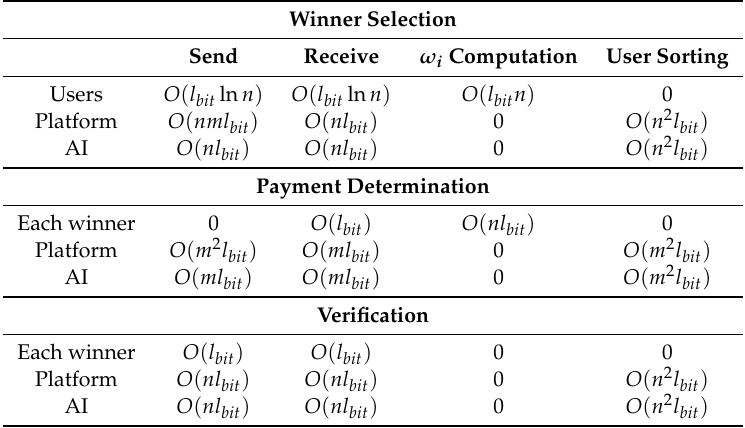
Table 4. Communication overhead of PVI-S.